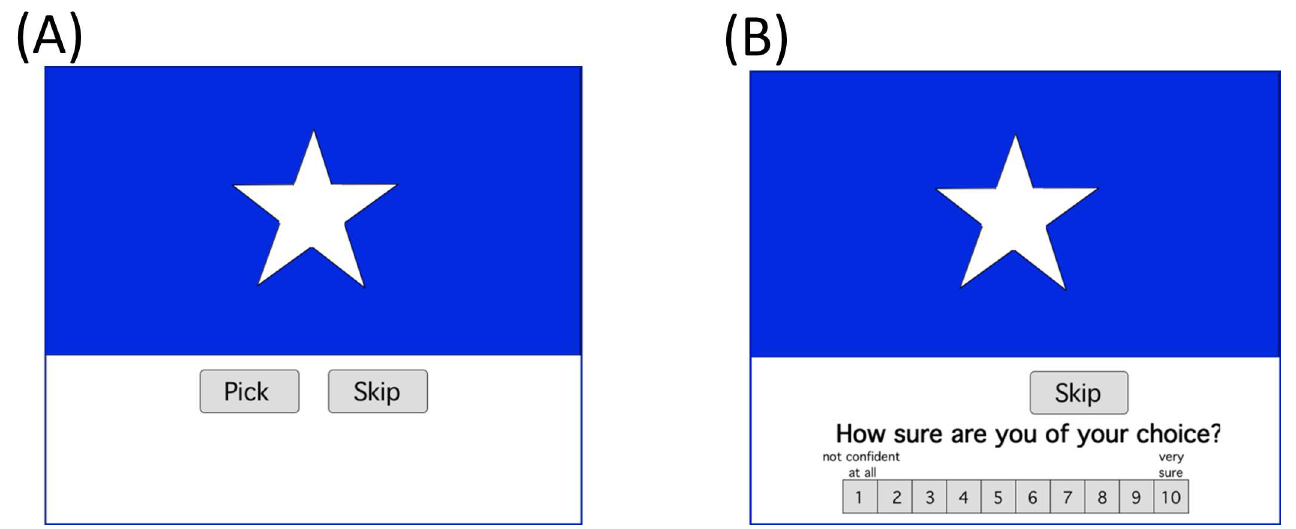
Fig 2. Sample screen events during a test trial. (A) Here, a negativeobject (star) is presentedagainsta new context (blue), and the participantis asked to “pick” or “skip”. (B) After each response, the participantis asked to rate confidencein this choice on a Likert scale from 1 =“not confidentat all” to 10 =“very sure.” No feedbackis provided duringthe testing